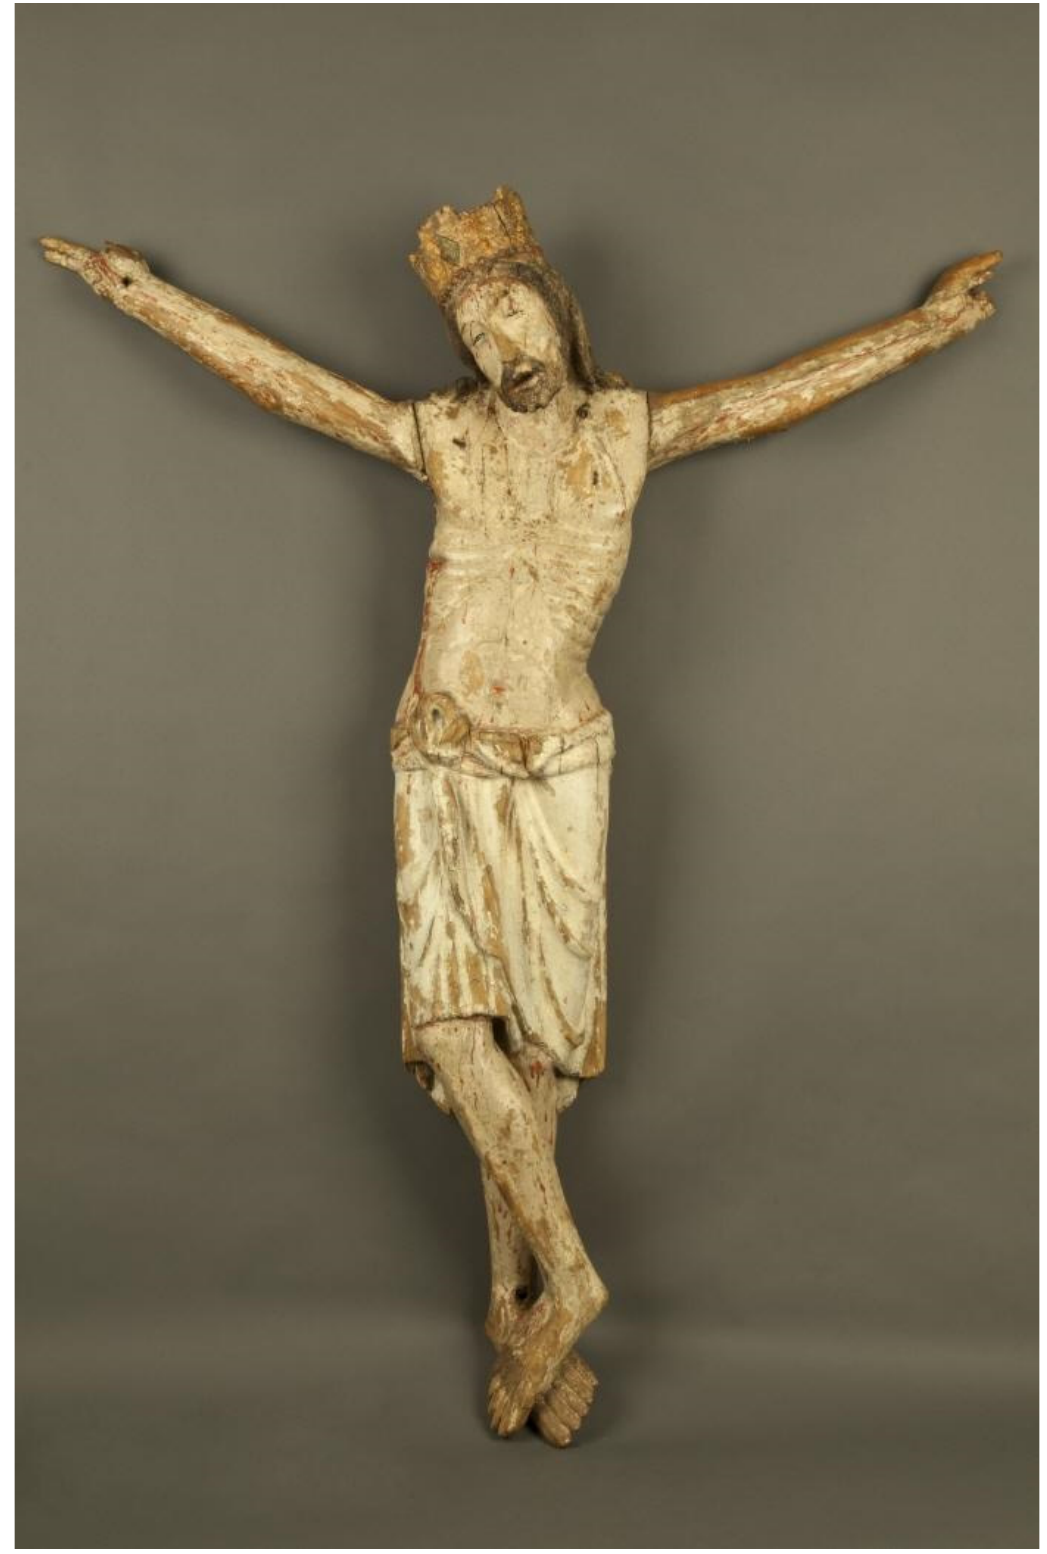
Figure 4. Crucifix, 1250–1300, Museo Nacional de Escultura (Valladolid). (© Museo Nacional de Escultura, Valladolid (Spain); Photograph: Javier Muñoz y Paz Pastor).